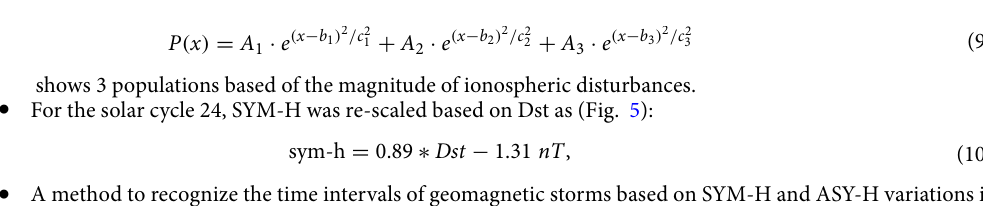
shows 3 populations based of the magnitude of ionospheric disturbances.